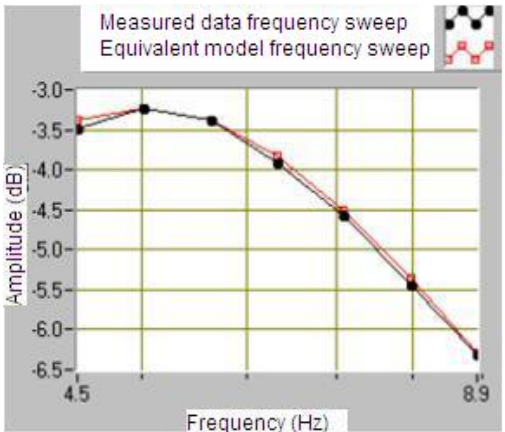
Figure 14. Comparative with data measured and calculated of the geophone SM-6 sensitivity in dB through the frequency.